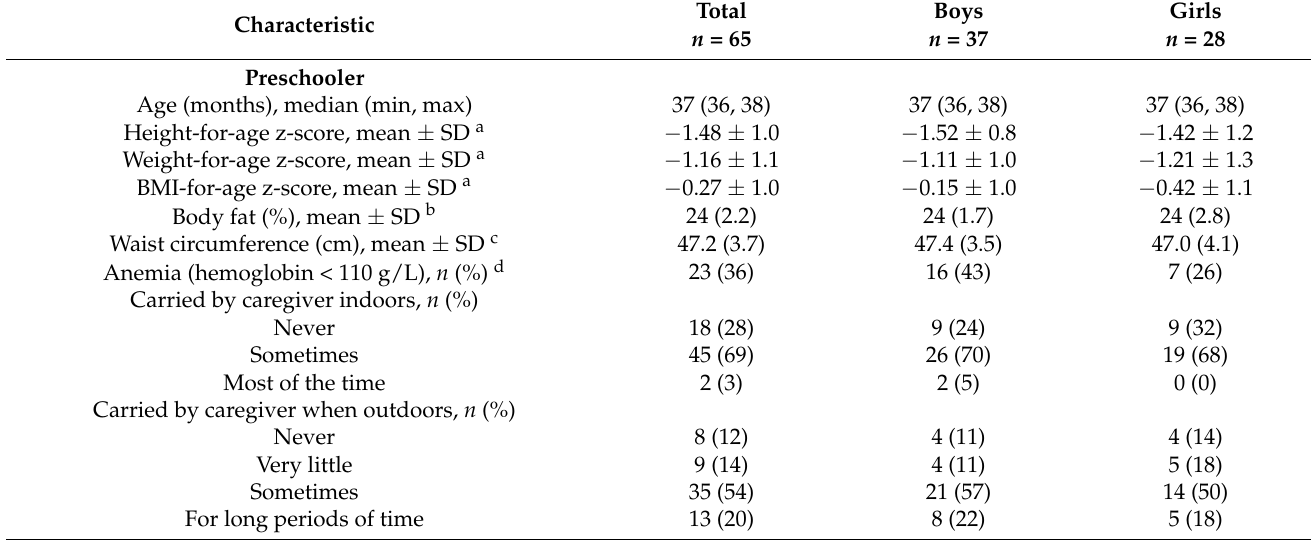
Table 1. Characteristics of study participants, their mothers, and the home